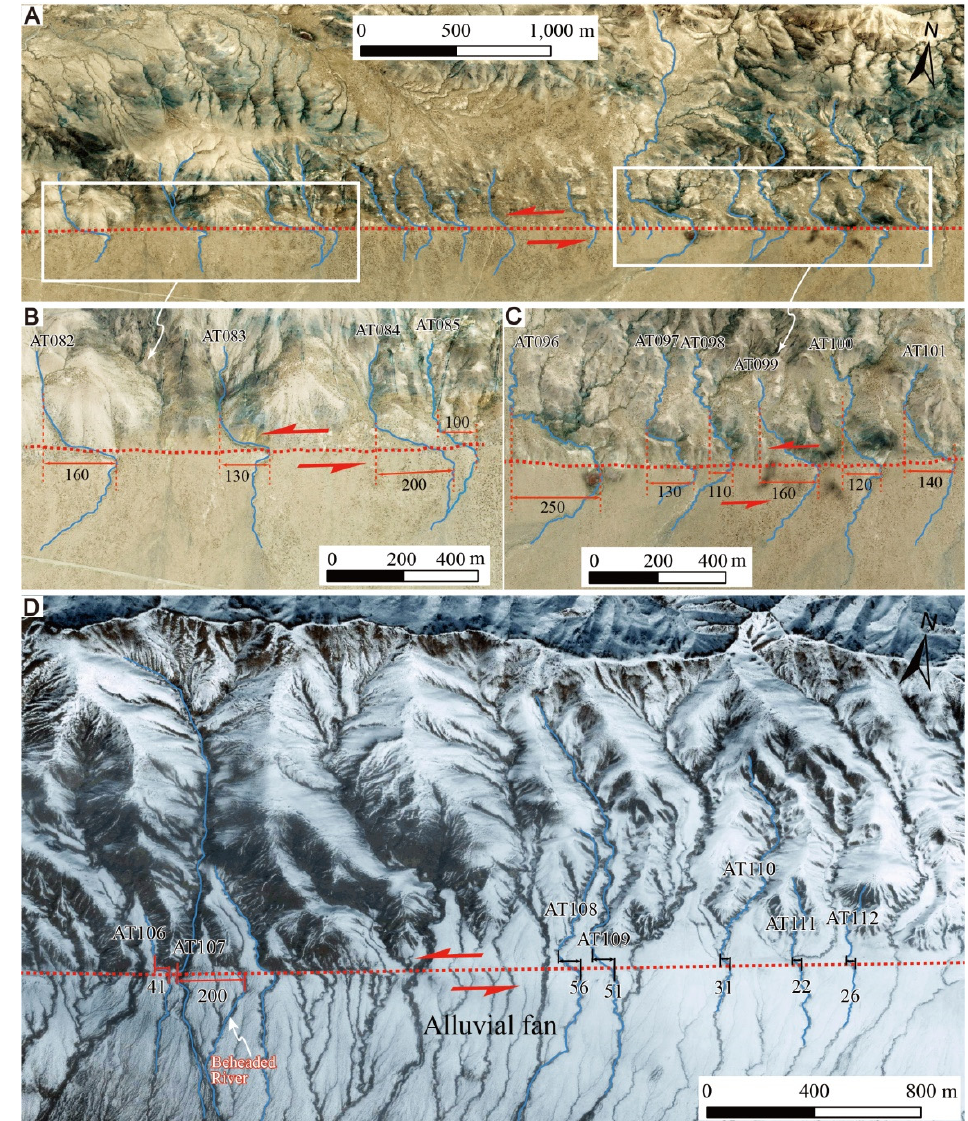
Figure 6. ( A – D ) Google earth images showing the tectonic geomorphology and systematic deflection of stream channels, of which the downstream channels developed in the alluvial fan deposits (AT082–AT085, AT096–AT101, and AT106–AT112) associating with left-lateral strike-slip faulting along Altyn Tagh Fault (see Figure 1B for location, Table S1 for measurement uncertainty). All the offsets are in meters.